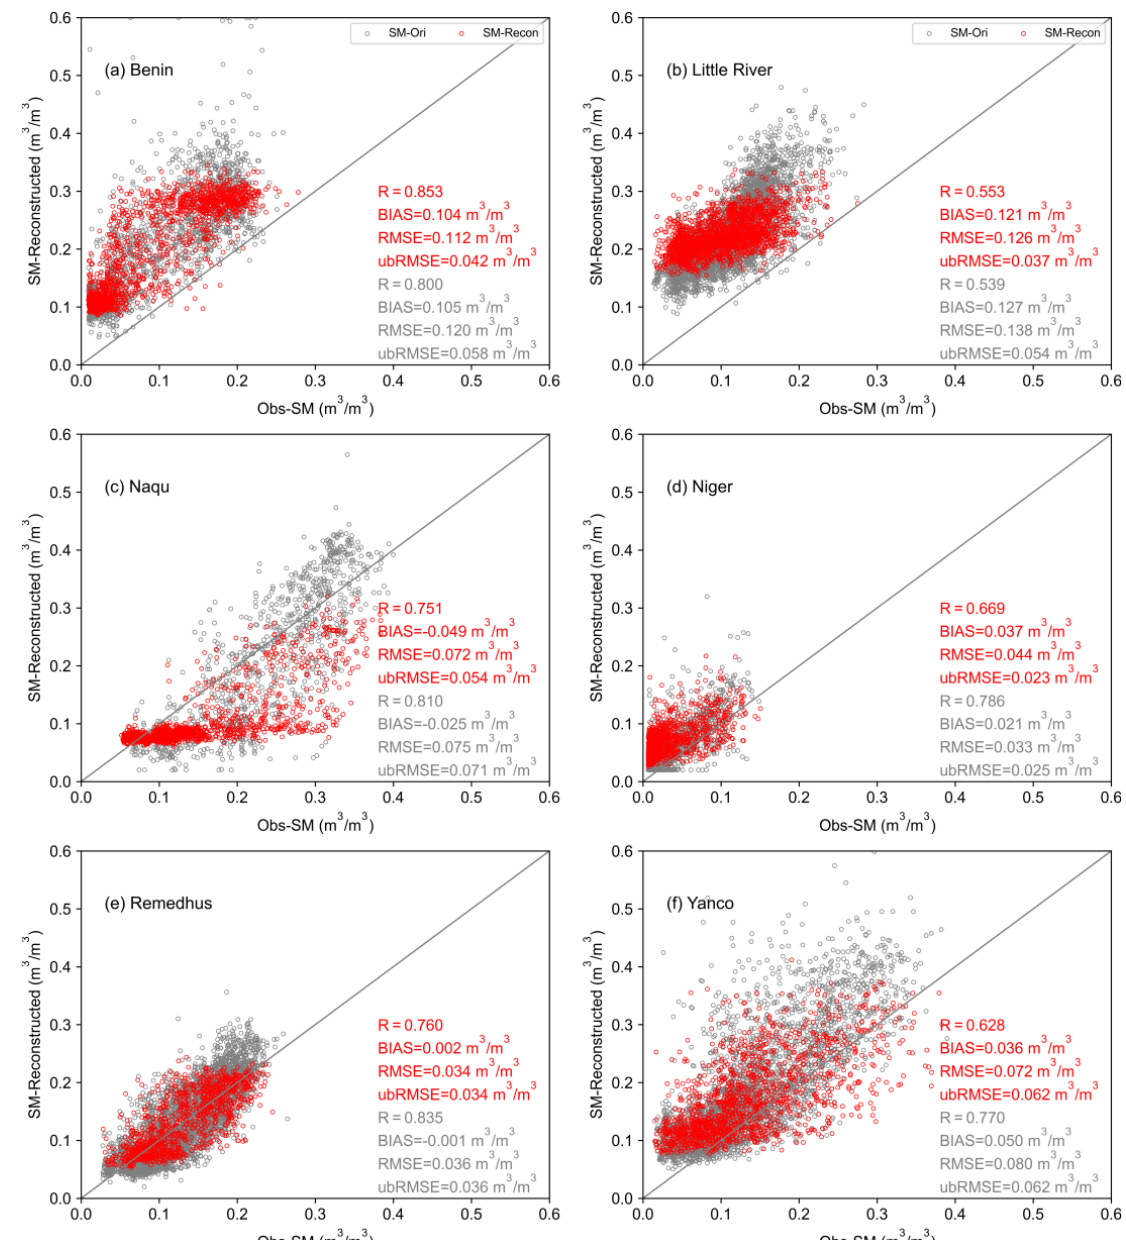
Figure 16. Scatter plots of the SM-Ori and SM-Recon values against Obs-SM ( x -axis) for 2002–2020 over the selected 6 validation sites.